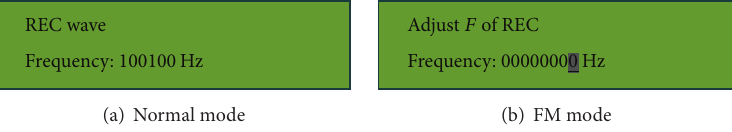
Figure 22: The LCD working sketches under the state of square